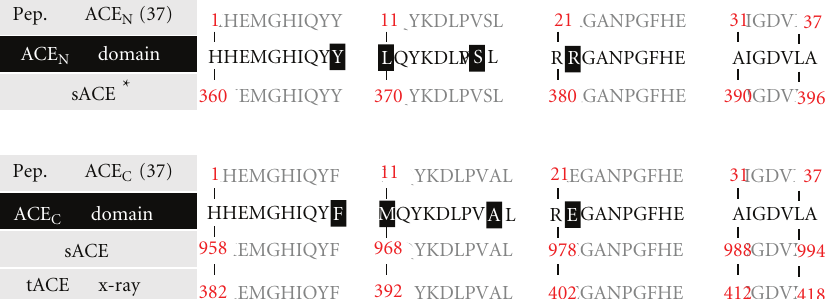
Figure 1: Synthetic peptide maquettes of the N- and C- active site domains of human somatic ACE (sACE). Sequence numbering of peptides, sACE, testis isoform (tACE) and crystal structures domains. The di ff erent residues among the two sequences are highlighted.